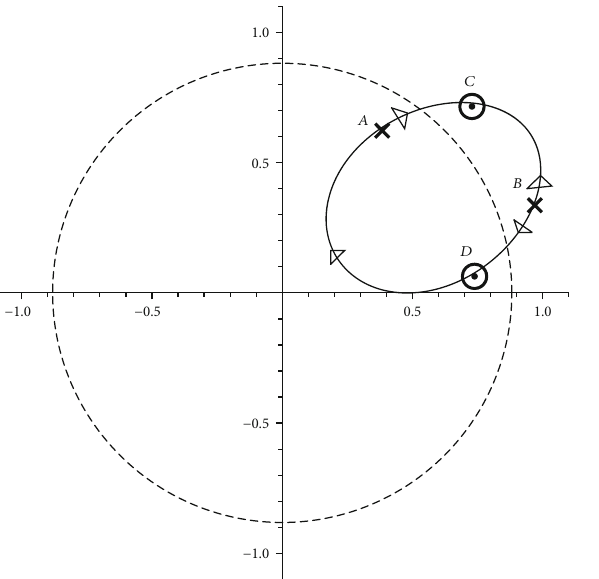
Figure 3: A plot of the spatial path of a light ray in the z = 0 plane in the Gödel metric. The light ray is emitted from x = 0 : 5 and travels counterclockwise. According to an observer at the origin, when the light ray has reached A by moving directly from the initial point, a blue sky pair of pulses begins at B . Part of this pulse travels back towards the original pulse and annihilates at C with the initial pulse, when the forward moving pulse is at D . Both the annihilation and blue sky positions are hidden from the observer at the origin due to the circle that delineates the causally connected region.